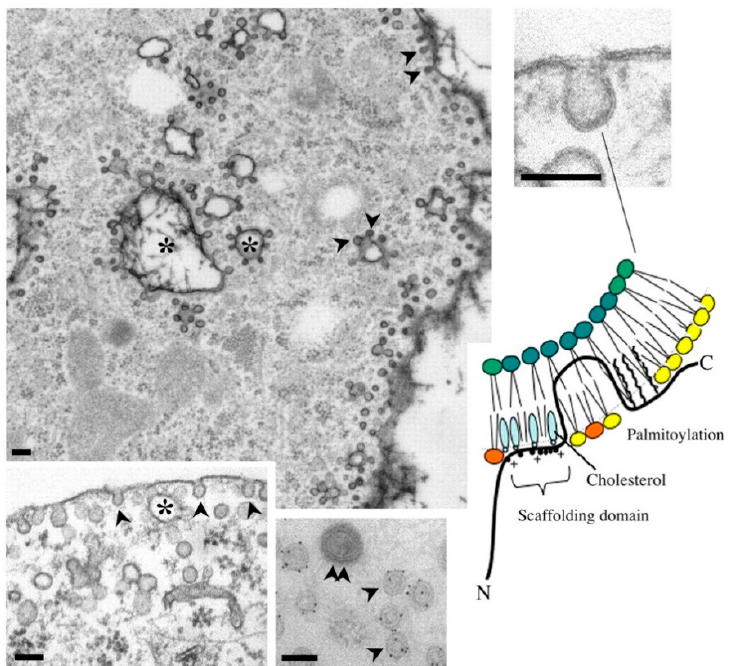
Figure 2. Cav-1-mediated signal transduction through the Caveolin-Scaffolding-Domain (CSD) [39] that interacts with a CSD-interacting motif (CIM) among the partner receptors [40] (adapted from [41]. Arrowheads indicate caveolae organelles. The “+” indicates the conserved amino acid residues of caveolin-interacting motifs (CIM): Φ X Φ XXXX Φ and Φ XXXX Φ XX Φ , where Φ is an aromatic residue (Trp, Phe, or Tyr) [40]. [Figure reproduced License 4.0 (CC BY-912)].